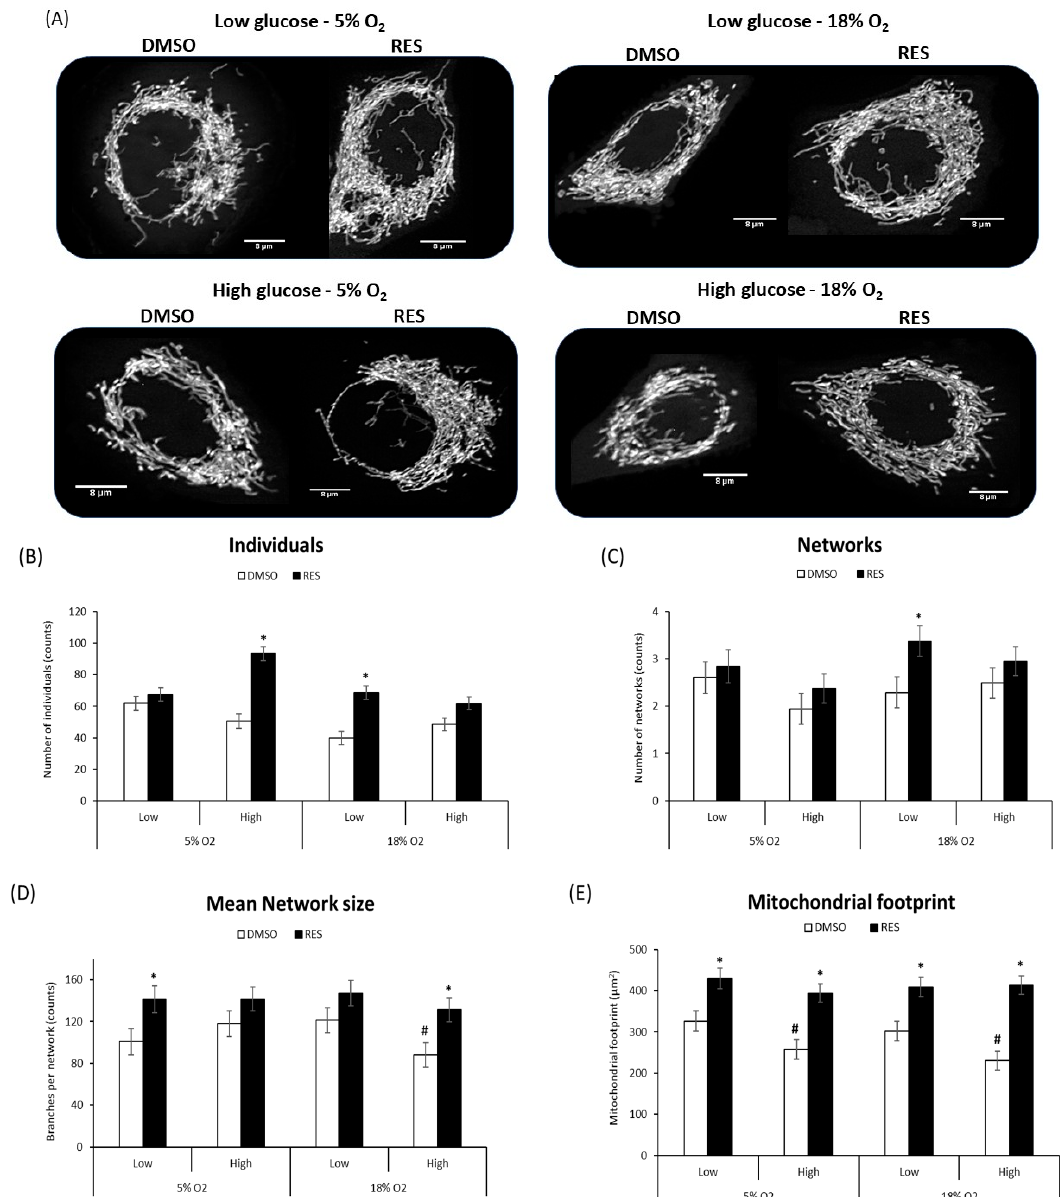
Figure 4. RES effects on mitochondrial network parameters are mostly unaffected by media glucose and oxygen levels in PC3 cells. Representative images of PC3 cells’ mitochondrial network parameters ( A ). There was a main effect of resveratrol on the number of individuals ( B ), networks ( C ), mean network size (branches per network) ( D ) and mitochondrial footprint ( E ). RES-treated cells showed an increase in all of these mitochondrial network parameters. An interaction between glucose and oxygen was also observed for mean network size (branches per network) ( C ). Main effect of glucose was observed in mitochondrial footprint ( D ). At low glucose levels mitochondrial footprint was increased. Total magnification in all experiments was 630 × . Cells were treated for 48 h with 10 µ M RES (filled bars) or an equal volume of vehicle control (DMSO; open bars). Data shown are means ± SEM of at least 3 independent experiments. For each condition at least 30 randomly selected individual cells were analyzed with MiNA. ‘*’ represents differences between RES-treated and DMSO-treated cells, p < 0.05. ‘#’ represents differences between low and high glucose levels, p < 0.05. ‘$’ represents differences between low and high oxygen levels.